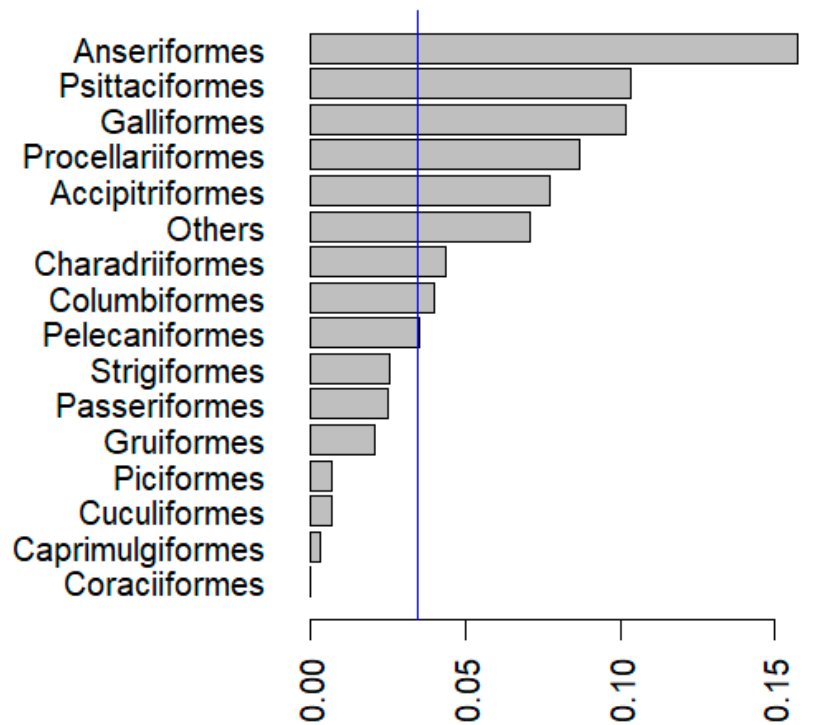
Figure 2. Proportions (number of APV species in particular order/number in order. The blue line shows the expected level of 0.035% derived from the number of species in which APV has been detected/avian species. We found that the number of species infected with APV was higher than expected in six avian orders (Anseriformes, Psittaciformes, Galliformes, Procellariformes, Accipitriformes and “others”), lower than expected in four avian orders (Passeriformes, Piciformes, Caprimulgiformes and Coraciiformes), and did not differ from expectation in the remaining five orders.